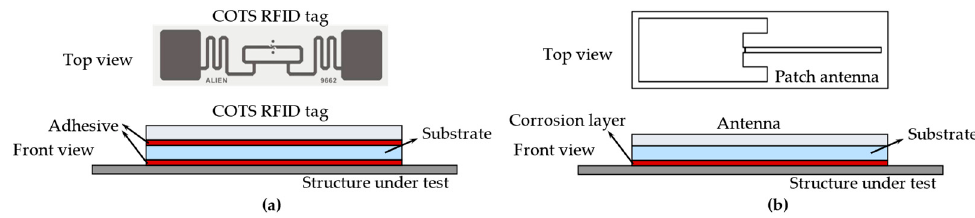
Figure 5. Diagram of RFID crack and corrosion sensor using backscattering: ( a ) COTS RFID tag as a crack sensor; ( b ) antenna-based RFID tag as a corrosion sensor.